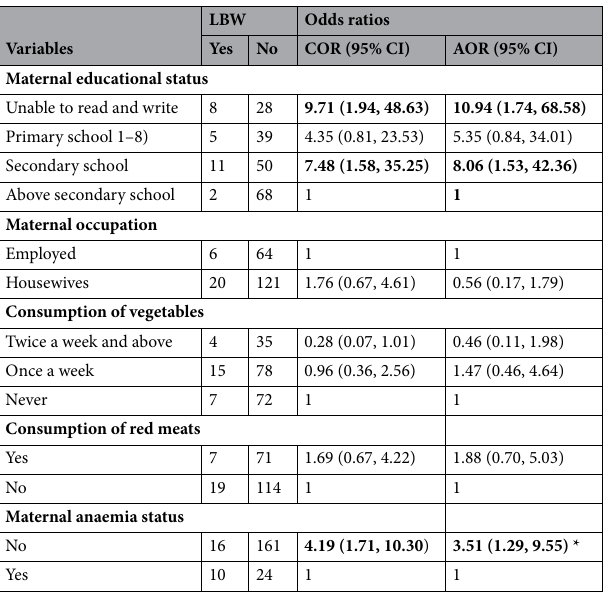
Table 3. Binary and multivariable logistic regression analysis of factors associated with low birth weight among newborns in Northwest Ethiopia, 2019 (n = 211). LBW, low birth weight; *shows statistically significant p < 0.05; 1 = reference group; AOR, adjusted odd ratio; COR, crude odd ratio. Significant values are in